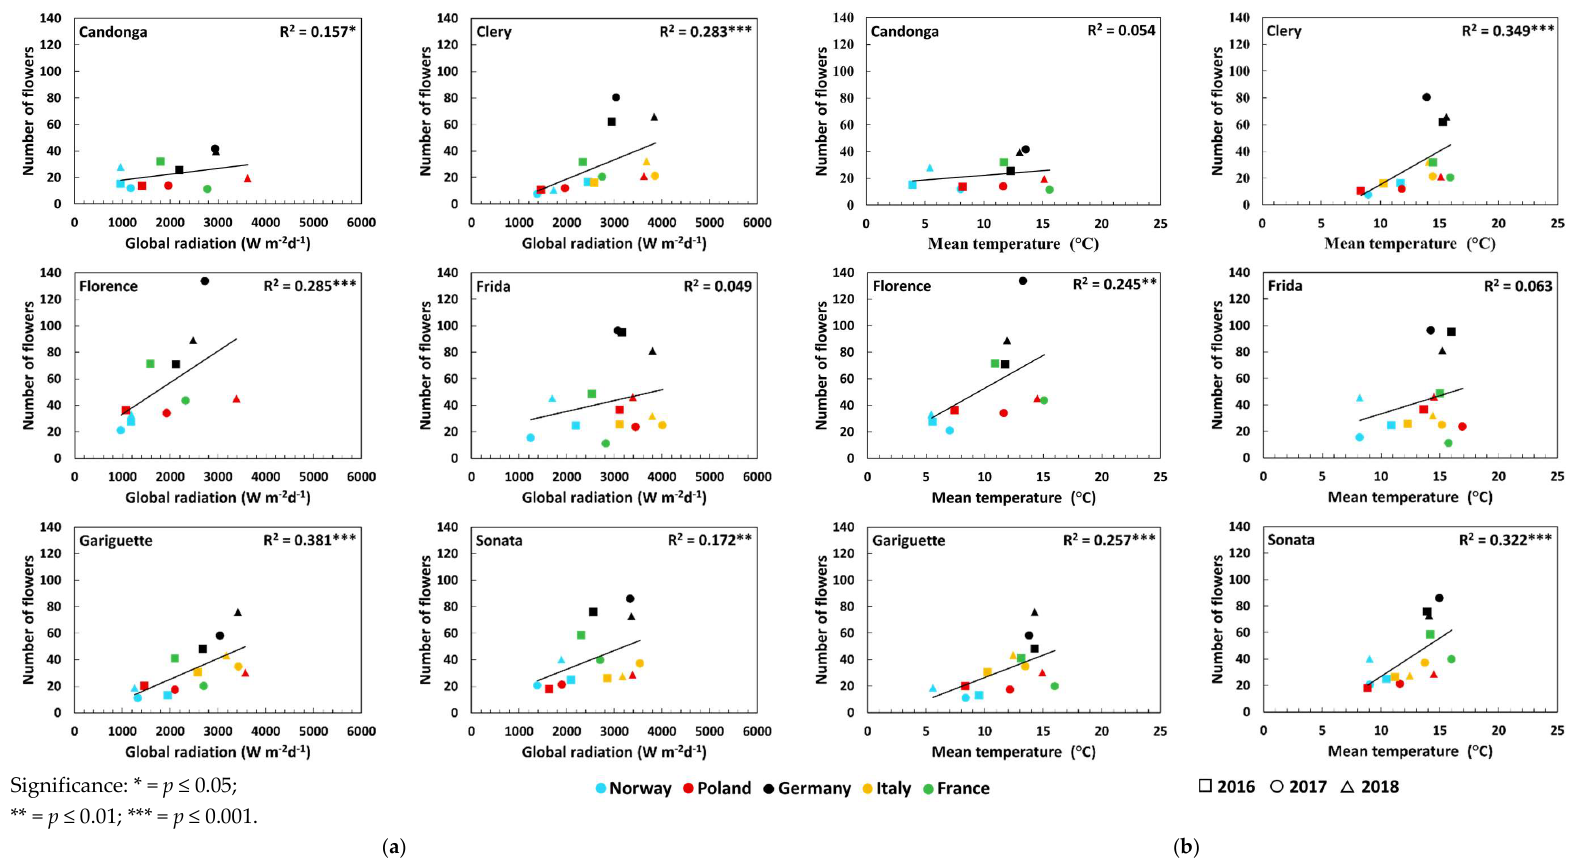
Figure 6. Number of flowers of six cultivars grown at five locations in Europe as influenced by ( a ) global radiation and ( b ) mean temperature during the 5-week period after flower initiation in 3 years.